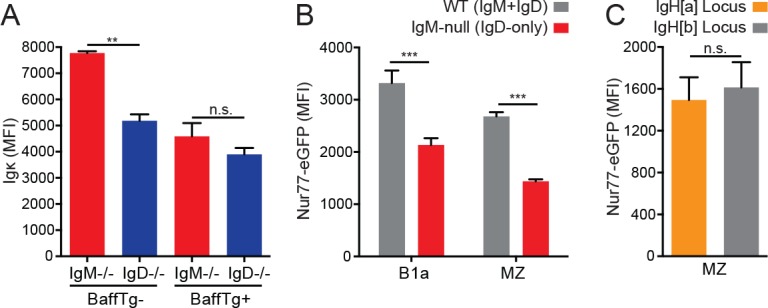
The effect of BAFF, competition, and allotype on Igκ and Nur77-eGFP expression.(A) Surface Igκ MFI of IgM−/− and IgD−/− splenic MZ B cells from mice without (left) and with (right) a BAFF overexpression transgene. (B) Nur77-eGFP expression in peritoneal B1a and splenic MZ B cells from IgM-null (IgDa+) and WT (IgMb+) loci in IgM+/− mice. (C) Nur77-eGFP expression in IgMa+ and IgMb+ splenic MZ B cells in 6-month-old IgHa/b mice with a BAFF overexpression transgene. Values in (A) were calculated from n = 3 mice of each genotype. Values in (B) and (C) were calculated in n = 6 and n = 4 mice, respectively. Welch’s t test (A) and a paired t test (B-C) were used to calculate p values, and mean +SEM is displayed. **p<0.01, ***p<0.001.